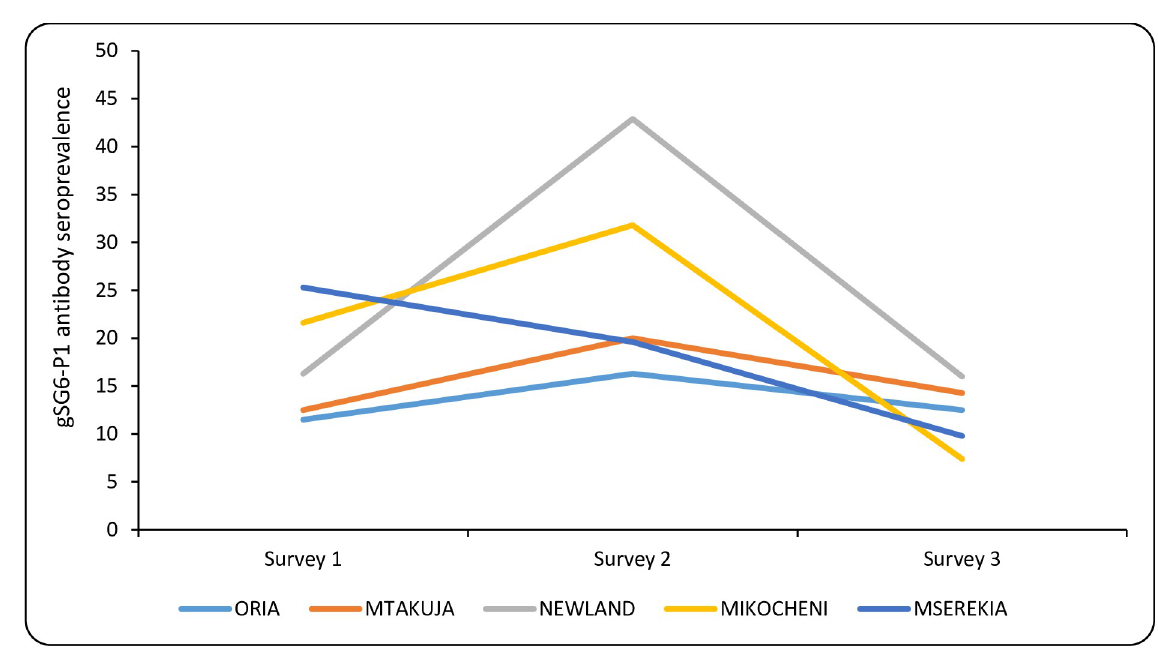
Fig 4. Temporal variation of gSG6-P1 seroprevalence for the five villages included in the study during the three